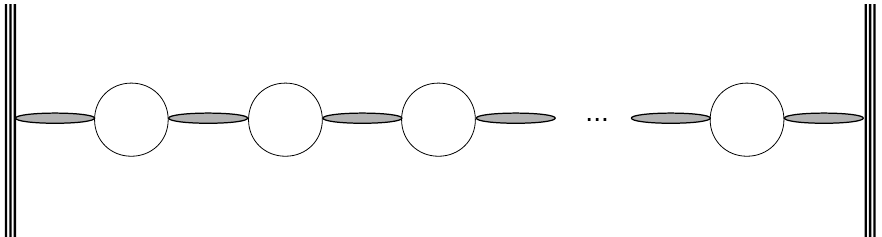
Figure 3. A linear chain of gluon bundles and quark loops exchange between two quarks of two nucleons. No more than two bundles can be attached to a quark loop [42].